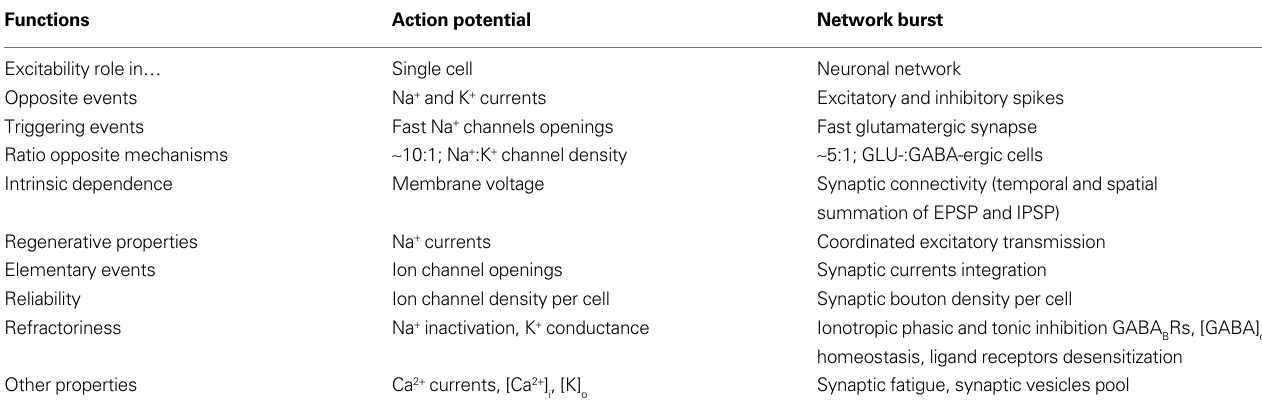
Table 3 | Comparison between action potential and network burst.